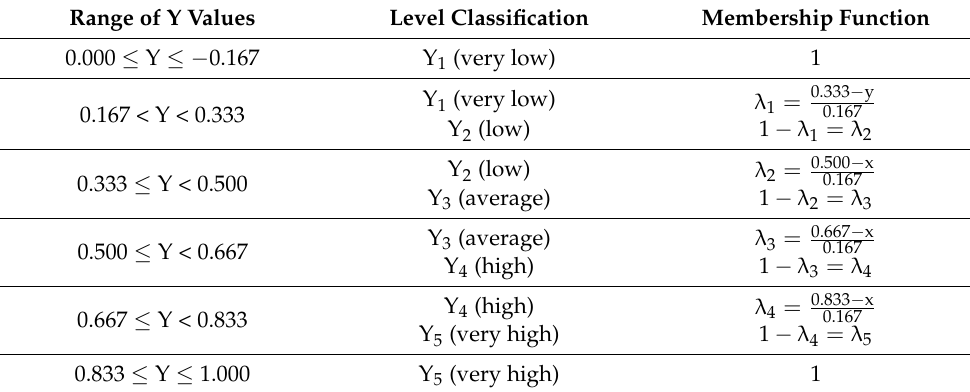
Table 3. Classification of the risk profile level.